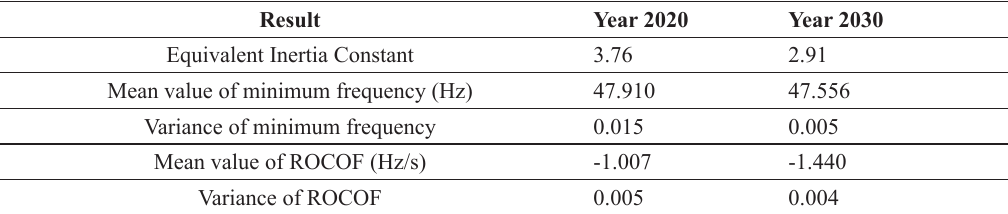
Figure 10: PDF curve of ROCOF for year 2030. Table 5: Summary of the